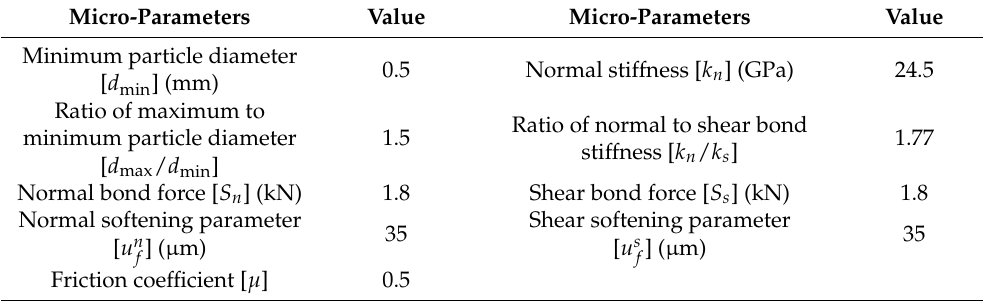
Table 6. Micro-parameters of linear cohesive model applied in the structural